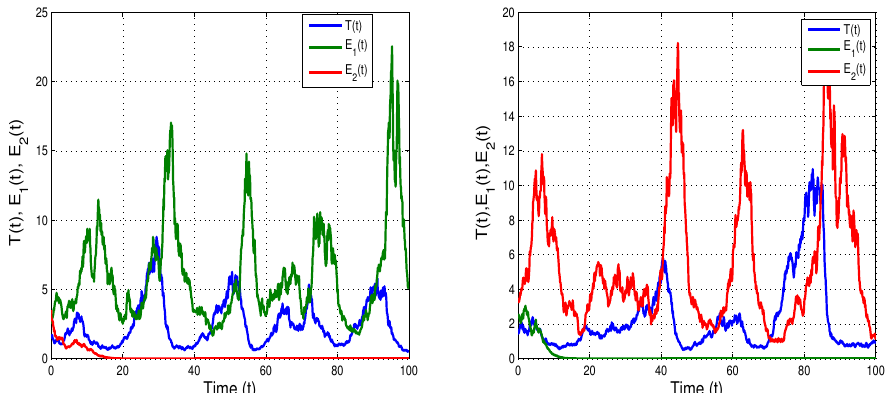
Figure 4. Shows time trajectories for tumor cells T ( t ) , and effector cells E 1 ( t ) , E 2 ( t ) of the stochastic model (6) with k 1 = 0.7, k 2 = 0.3, d 1 = 0.7, d 2 = 0.3 ( right banner) and k 1 = 0.3, k 2 = 0.7, d 1 = 0.3, d 2 = 0.7 ( left banner) and d − σ distribution is satisfied based on Theorem 2.